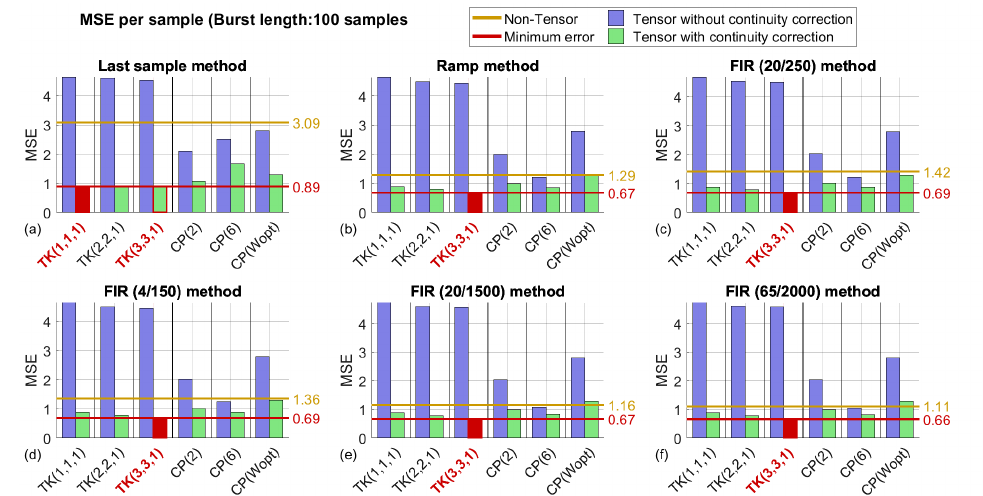
Figure 12. MSE of different value imputation methods. The results are the mean of 1000 simulations. The number of samples in the burst is 100. The position of the the burst is randomly selected. The tensor contains three weeks worth of data (288,7,3).